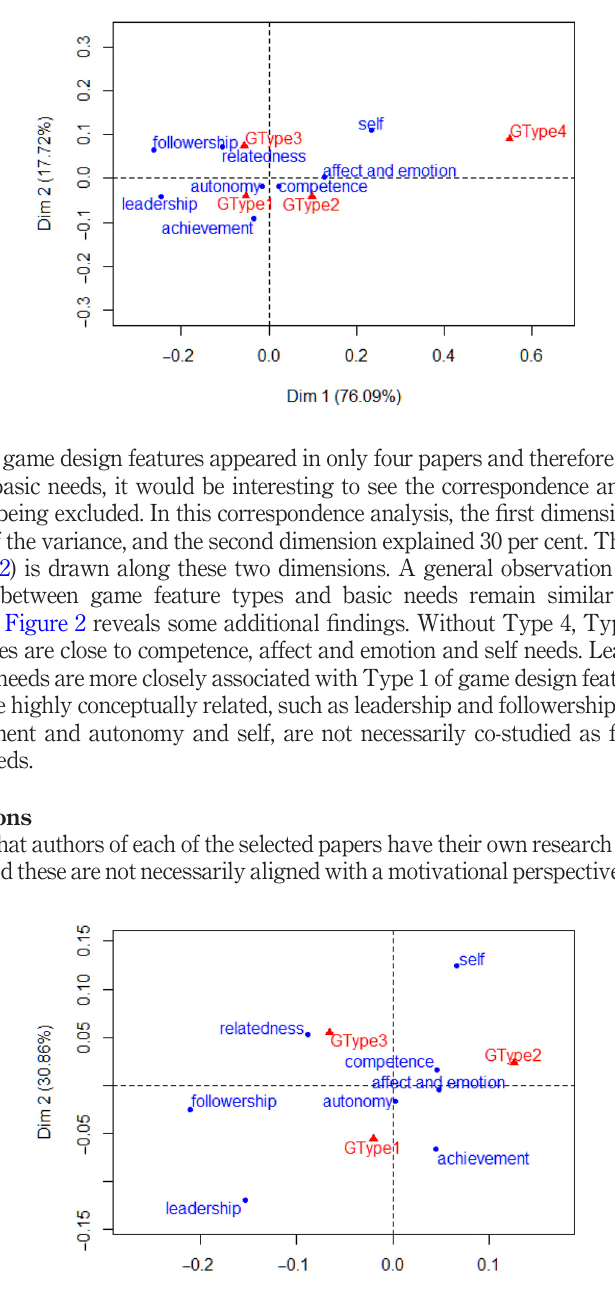
Figure 2. Three types of game design features